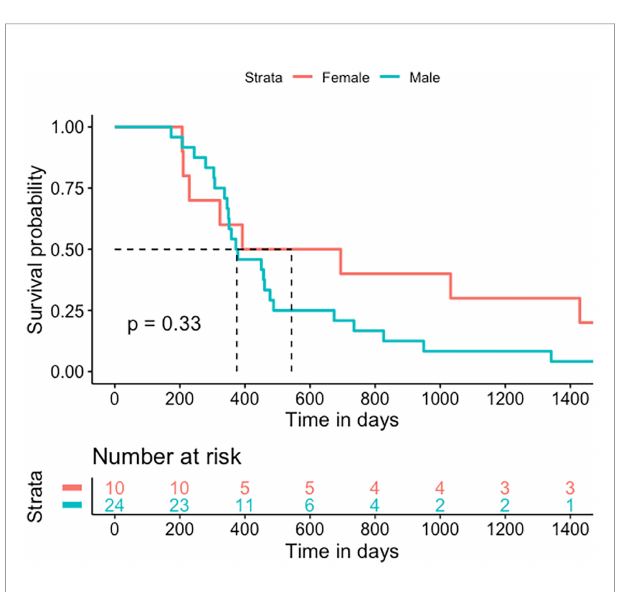
FIGURE 5 | Kaplan-Meier statistics for post-shunt survival. Shunt to death median survival was 130 days (IQR